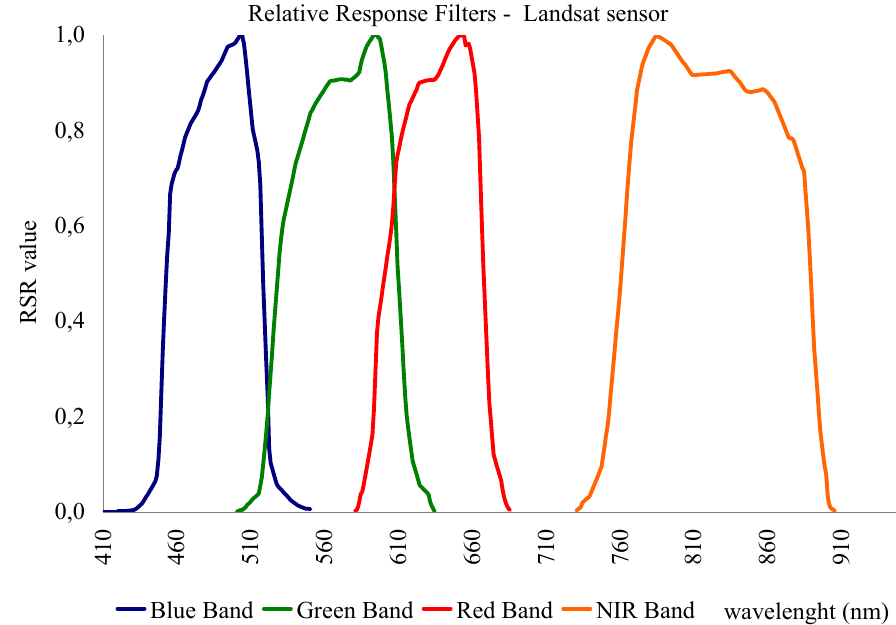
Figure 4. Relative Response filters for Bands 1-4 of Landsat TM sensor